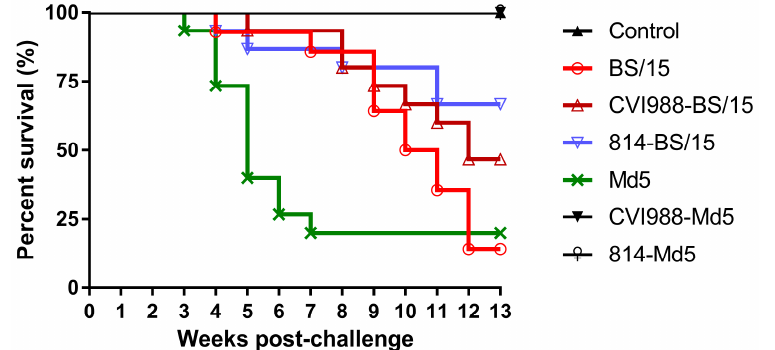
Figure 3. Survival curves for each group. The survival patterns between the BS/15-challenged group and Md5-challenged control group showed significant differences ( p < 0.05) by Log-rank (Mantel-Cox) test.